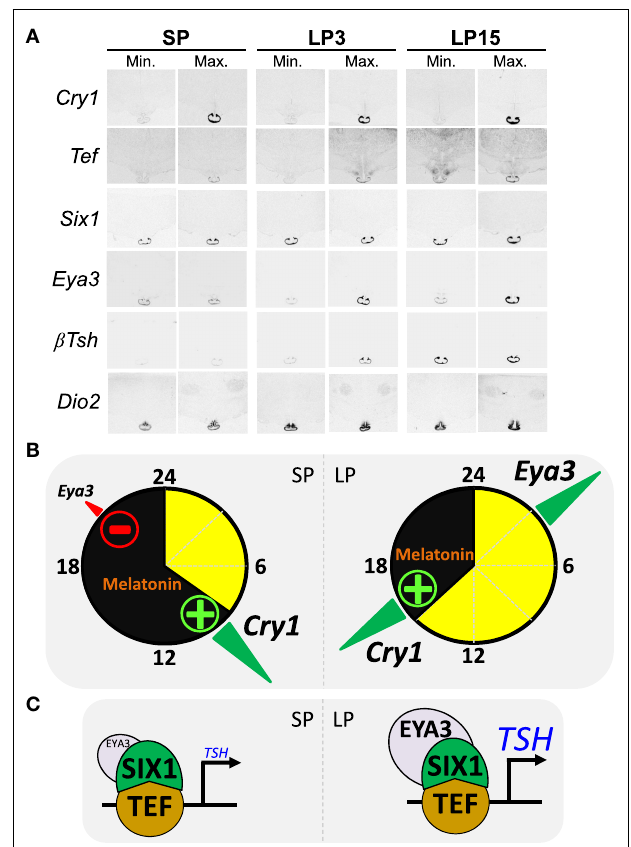
FIGURE 3 |The circadian clock of the pars tuberalis links melatonin to the photoperiodic response [after data from Dardente et al. (138) and unpublished data] . (A) Images representative of minimal and maximal mRNA levels in situ hybridization autoradiograms for Cry1 , Tef , Six1 , Eya3 , Tsh β , and Dio2 in sheep kept under SP 8:16 and sheep transferred to LP 16:8 for 3days (LP3) or 15days (LP15). (B) The internal coincidence model for photoperiodic time-measurement within the PT; SP situation on the left side, LP on the right side, yellow and black indicate day and night.The transcription of Eya3 is both clock-controlled and inhibited by melatonin, hence the phase-relationship relative to Cry1 expression (a melatonin- induced circadian gene) is similar irrespective of the photoperiod but Eya3 transcription increases only under LP as melatonin inhibition is relieved. (C) Schematics of the transcriptional control of the Tsh β gene byTEF/ SIX1/EYA3. Note that EYA3 levels are higher under LP than